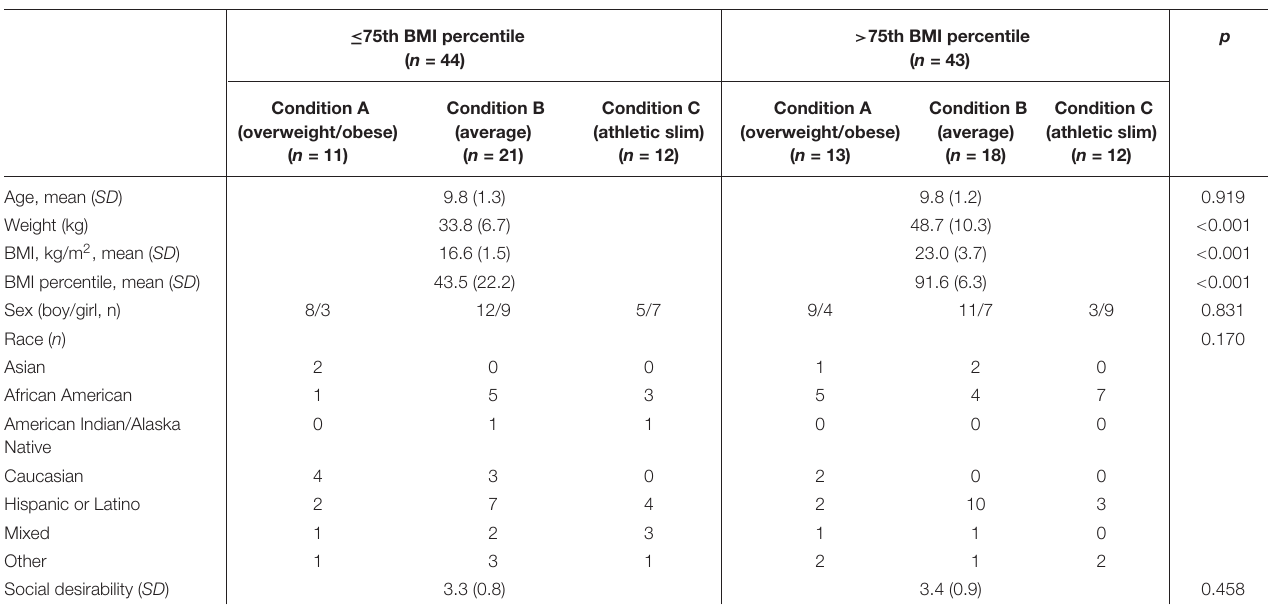
TABLE 1 | Participant demographics and social desirability results ( N =